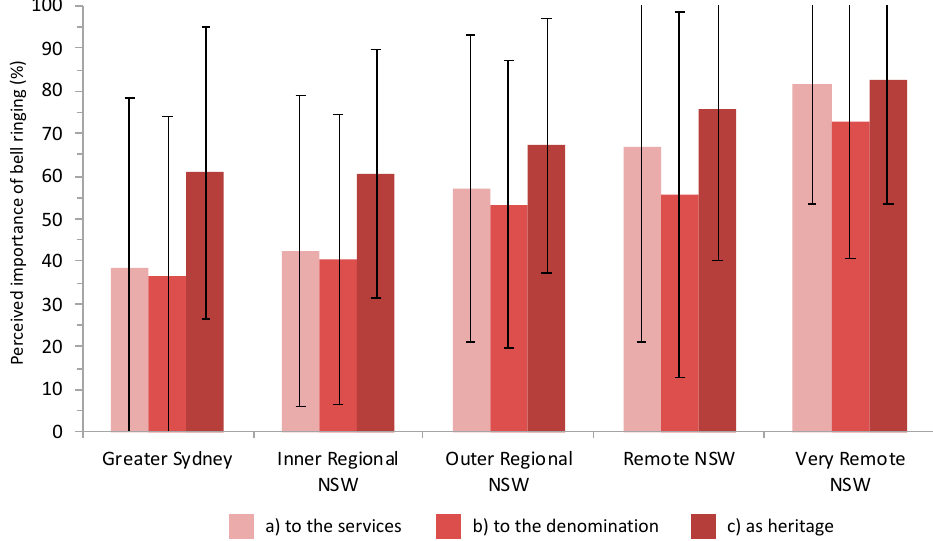
Figure 2. Average rating of importance of bell ringing ( a ) to the services at your church; ( b ) to your denomination overall; and ( c ) as a form of heritage, for all NSW Churches. Standard deviation bars shown.